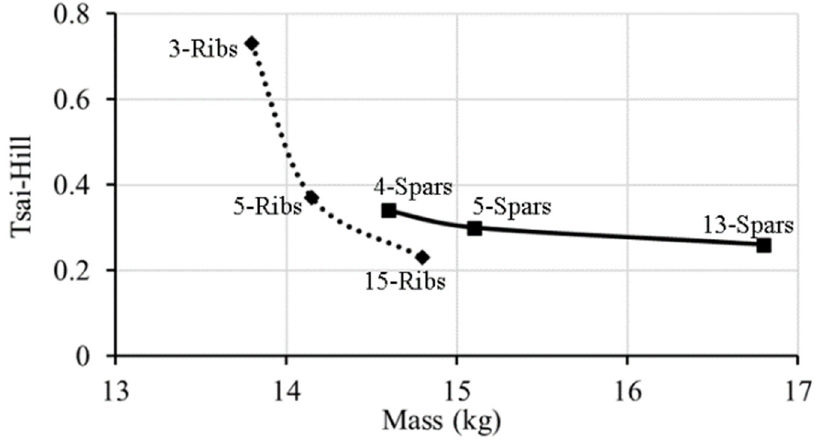
Figure 8. Comparison of Tsai–Hill in terms of mass between multi-spar and multi-rib configurations.